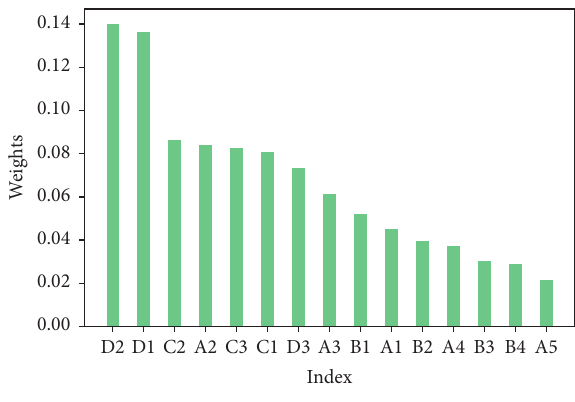
Figure 3: The weight of each